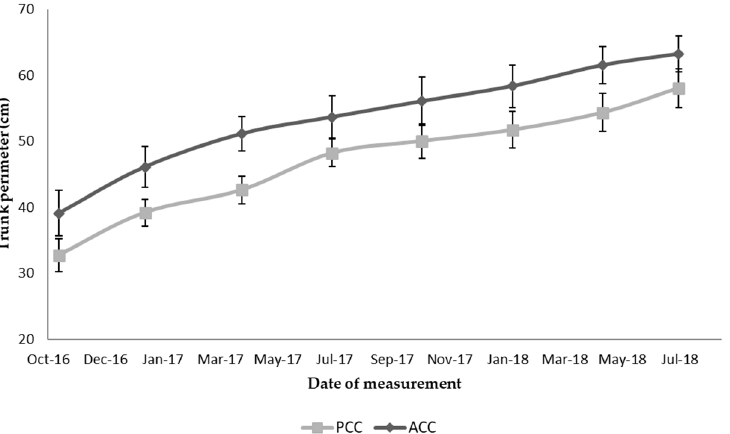
Figure 4. Trunk perimeter changes in “Siluet” papayas grown in passive climate control (PCC) and in active climate control (ACC) modules. Symbols represent the mean values of plant trunk perimeter while bars represent the standard deviations.